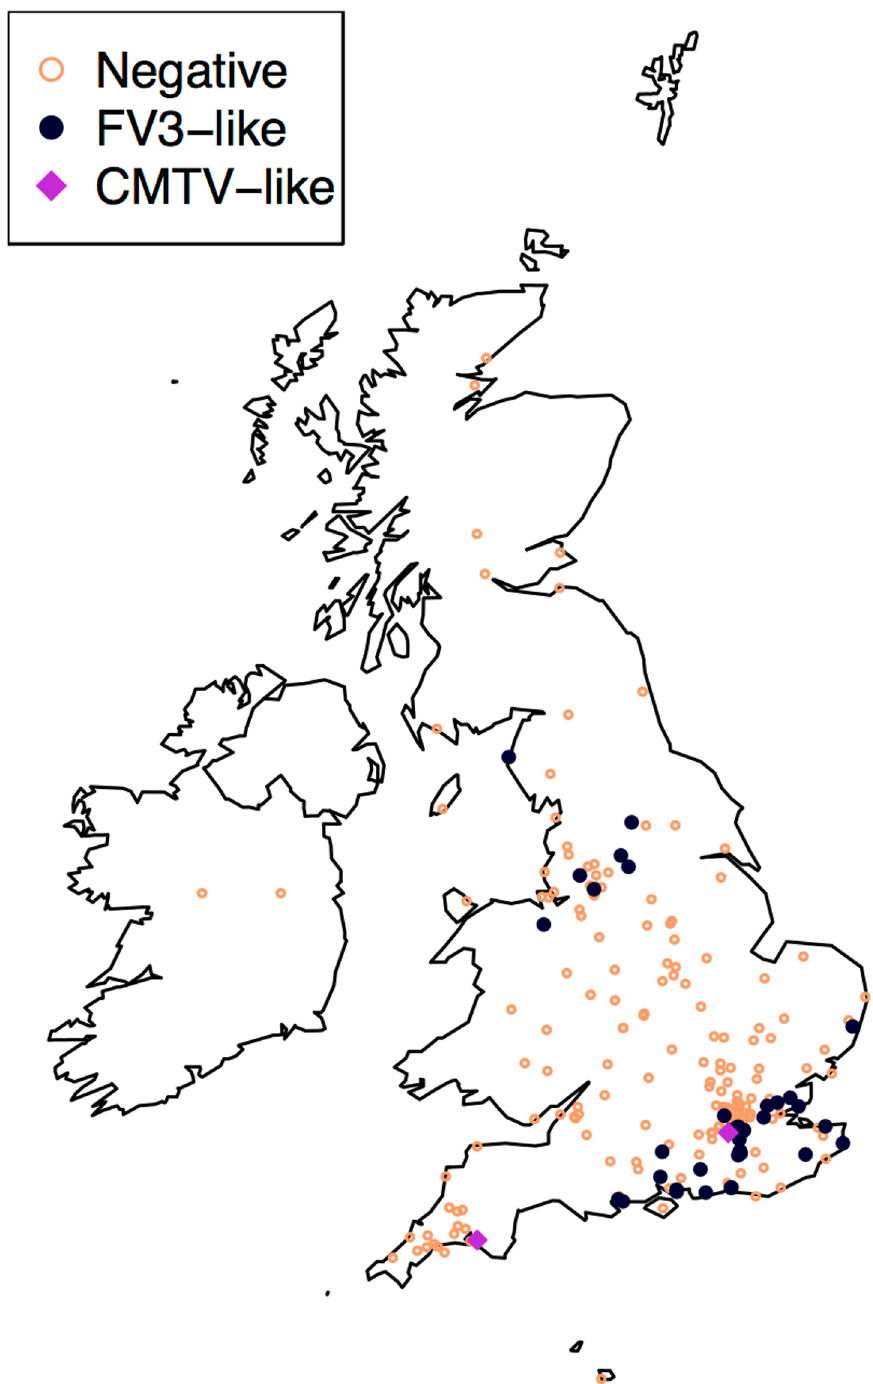
Fig 2. Geographical distribution of amphibian and reptilian samples tested for ranavirusin the British Isles. Colour and fill of points indicatesranavirusstatus (orangeoutline = negative)and virus genotypeof positives (black circle = Frog virus 3 (FV3)-like; purplediamond= common midwife toad virus (CMTV)-like). Due to missing data locationsof 14 incidentsare approximated to the highest resolution available(S1